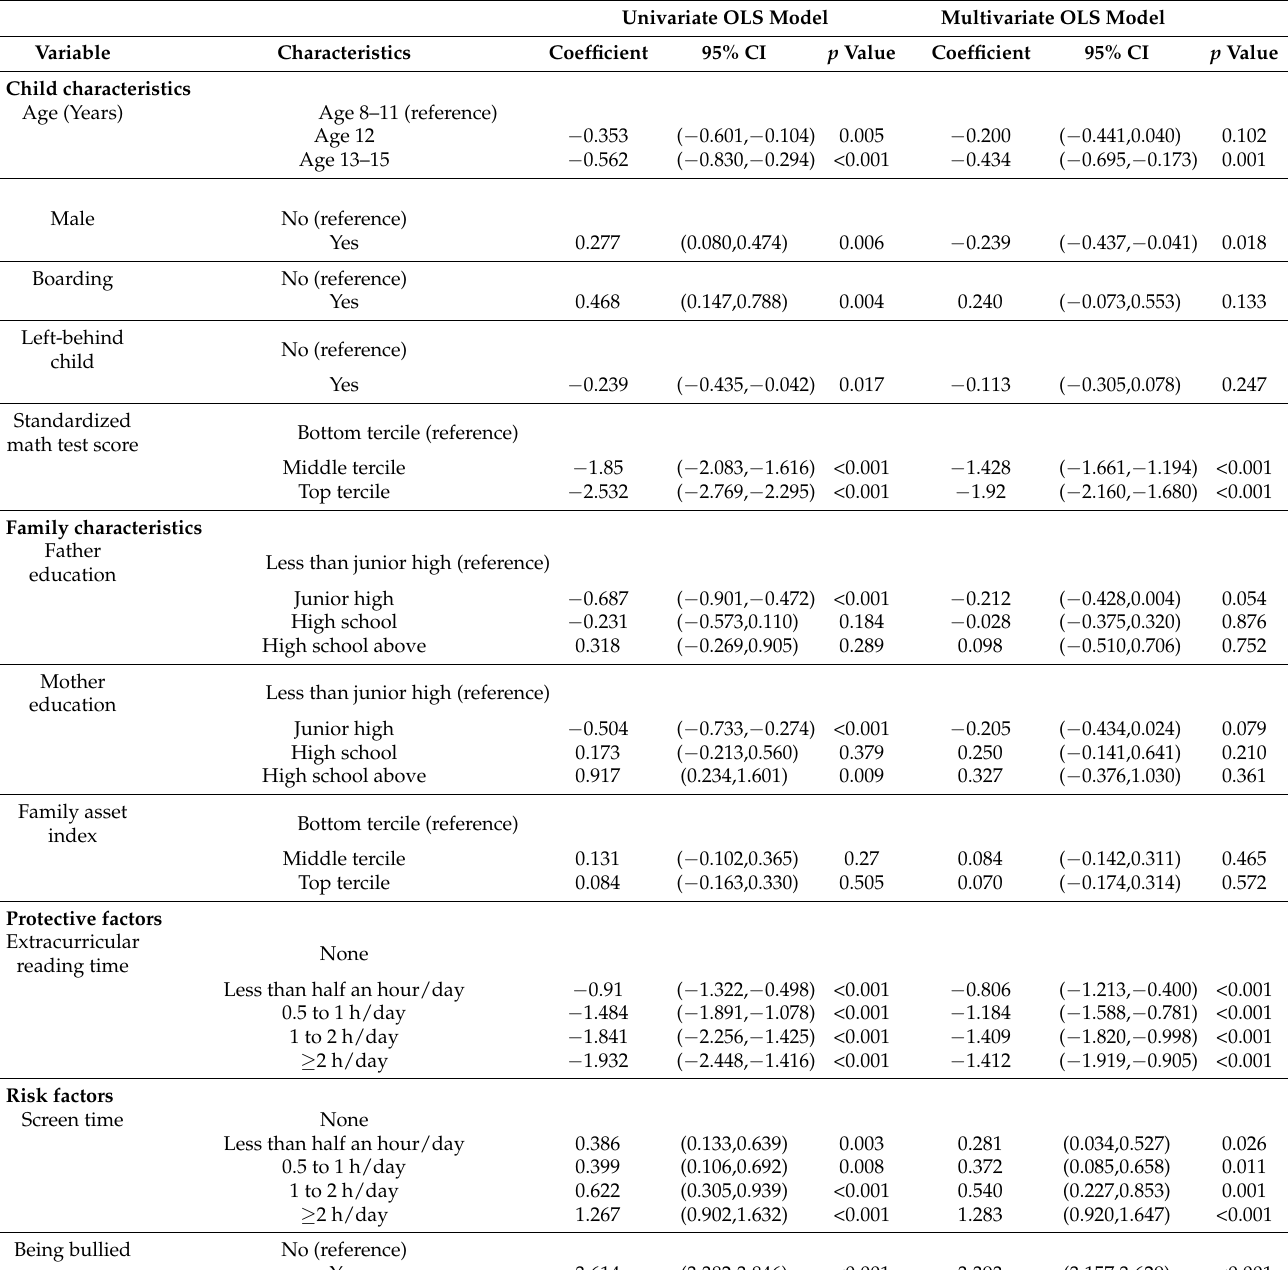
Table 4. OLS regression of factors associated with the Strengths and Difficulties Questionnaire total difficulties score. Univariate OLS Model Multivariate OLS